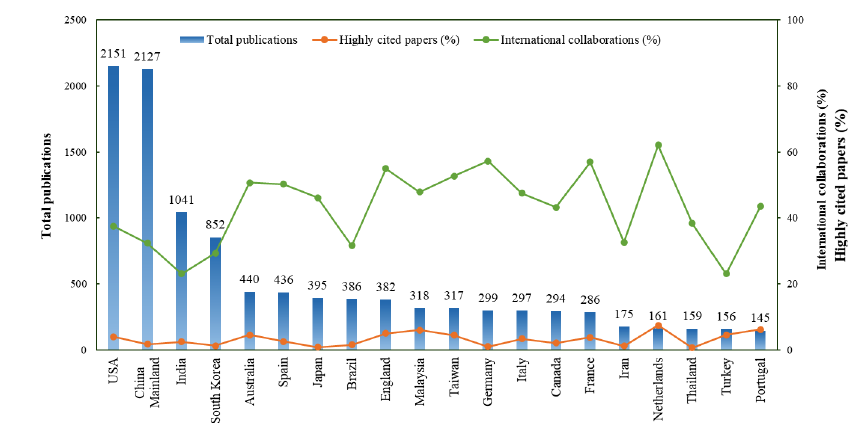
Figure 5. The primary characteristics of the top 20 most